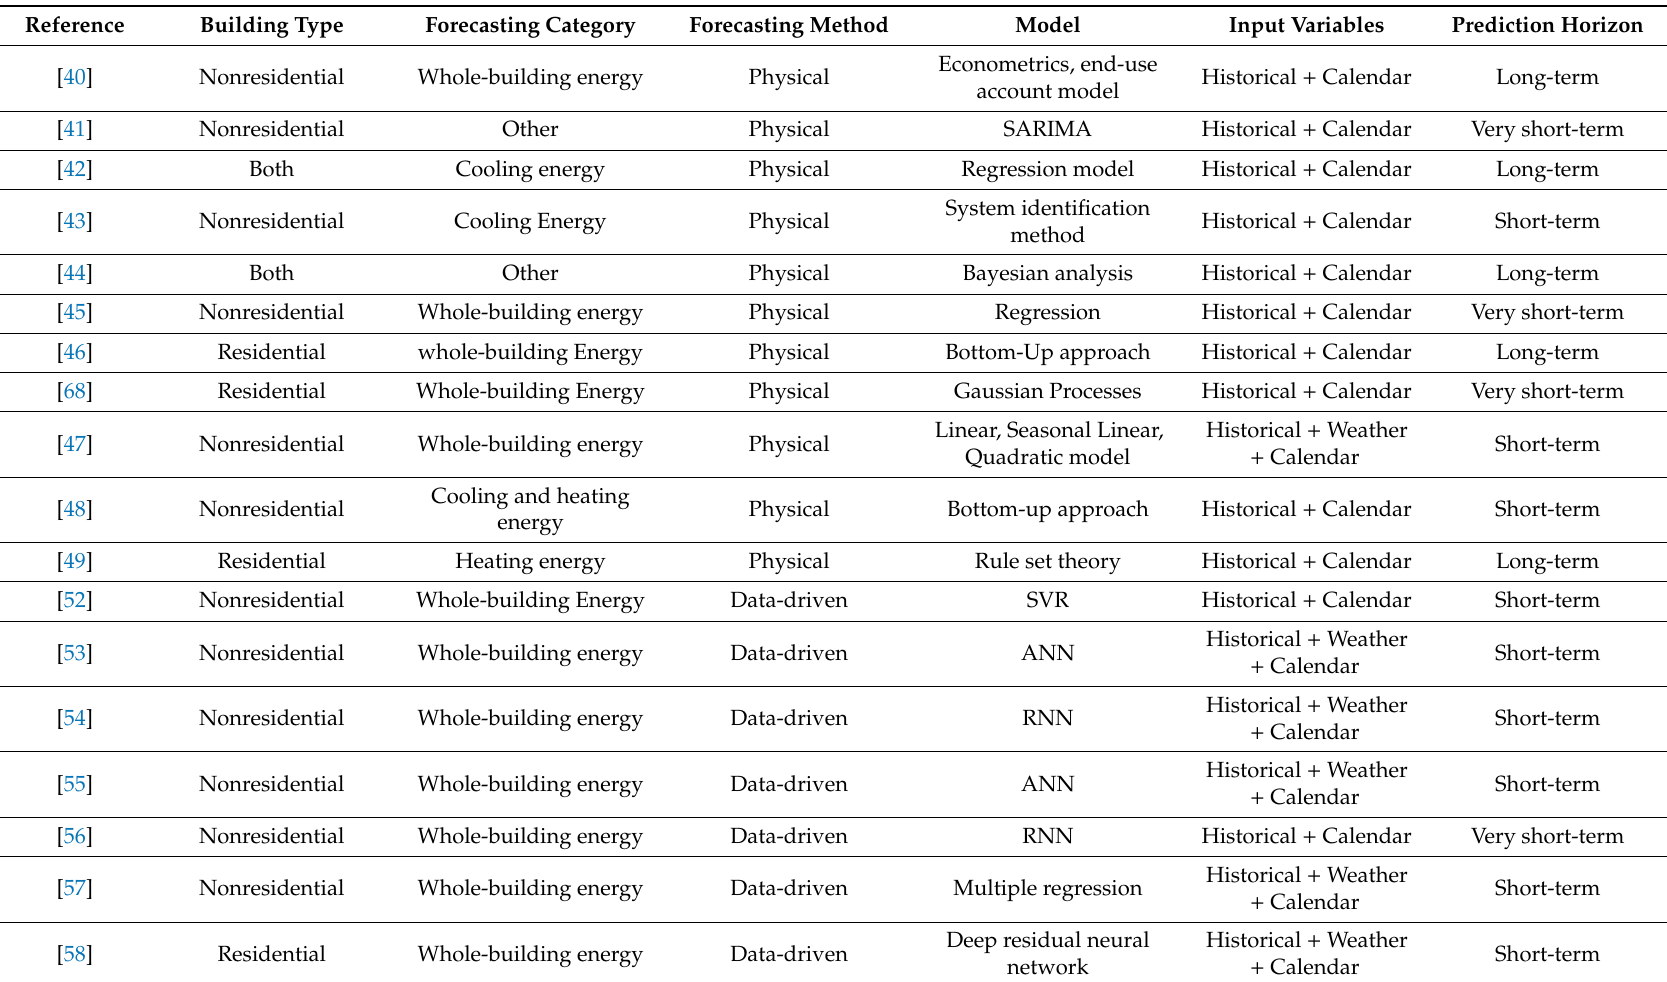
Table 4. Summary of previous research papers and their contributions to hybrid